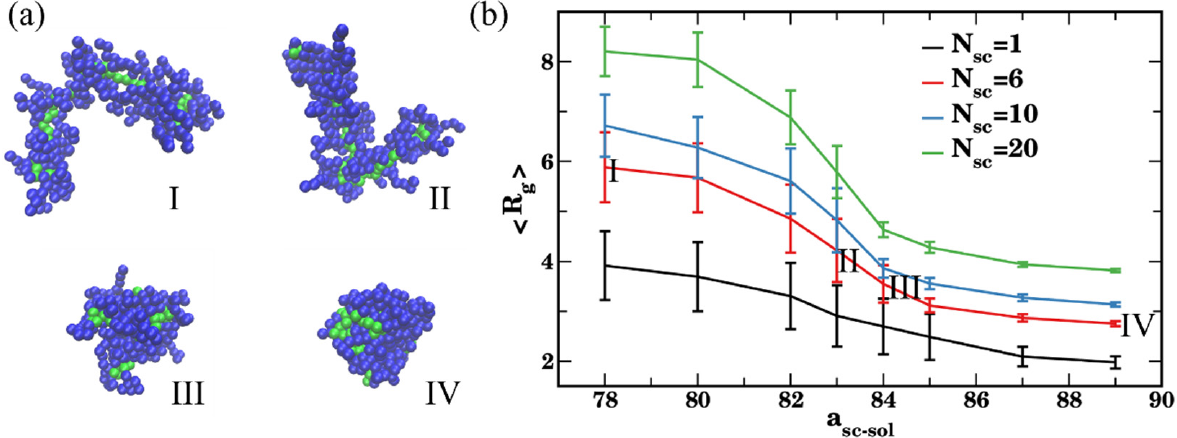
Figure 2. ( a ) Late time snapshots of a bottlebrush conformations (N sc = 6) in solvents of various quality: a sc-sol = 78 in (I), a sc-sol = 83 in (II), a sc-sol = 85 in (III), and a sc-sol = 89 in (IV). ( b ) Radius of gyration of the bottlebrush upon equilibration in solvents of various quality from the good solvent (a sc-sol = 78) to the poor solvent (a sc-sol = 89); black, red, blue, and green curves correspond to N sc = 1, 6, 10, and 20, respectively. The data are averaged over last 6 × 10 6 steps (1200 frames), error bars represent standard deviations.